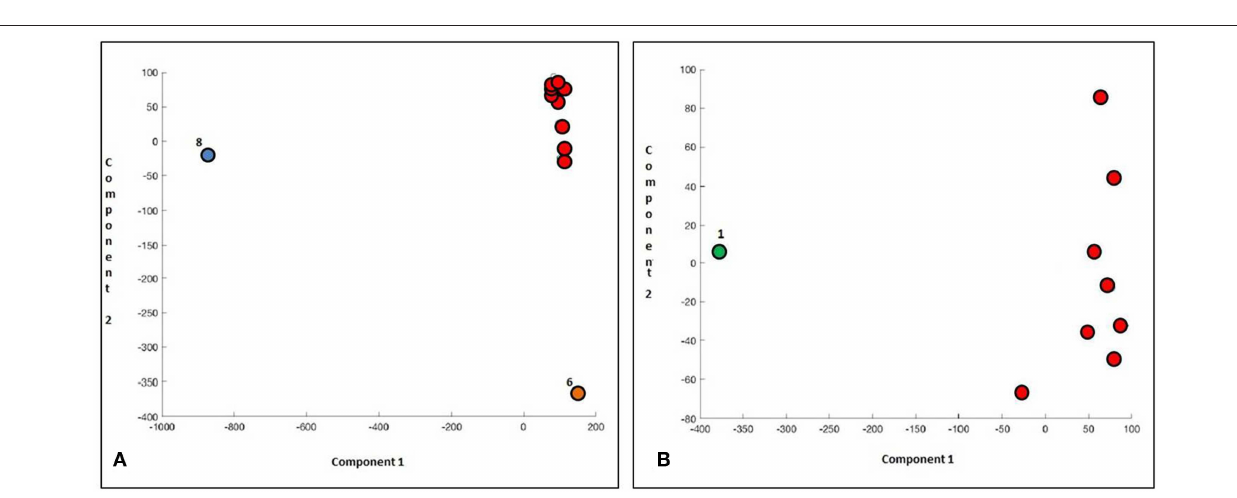
FIGURE 4 | Principal Component Analysis scores represented in a 2D scatter plot. One point per sample is shown. Different colors represent separation between PCA classes. (A) Analysis of 255 genes in all CML patients. (B) Patients #8 and #6 were